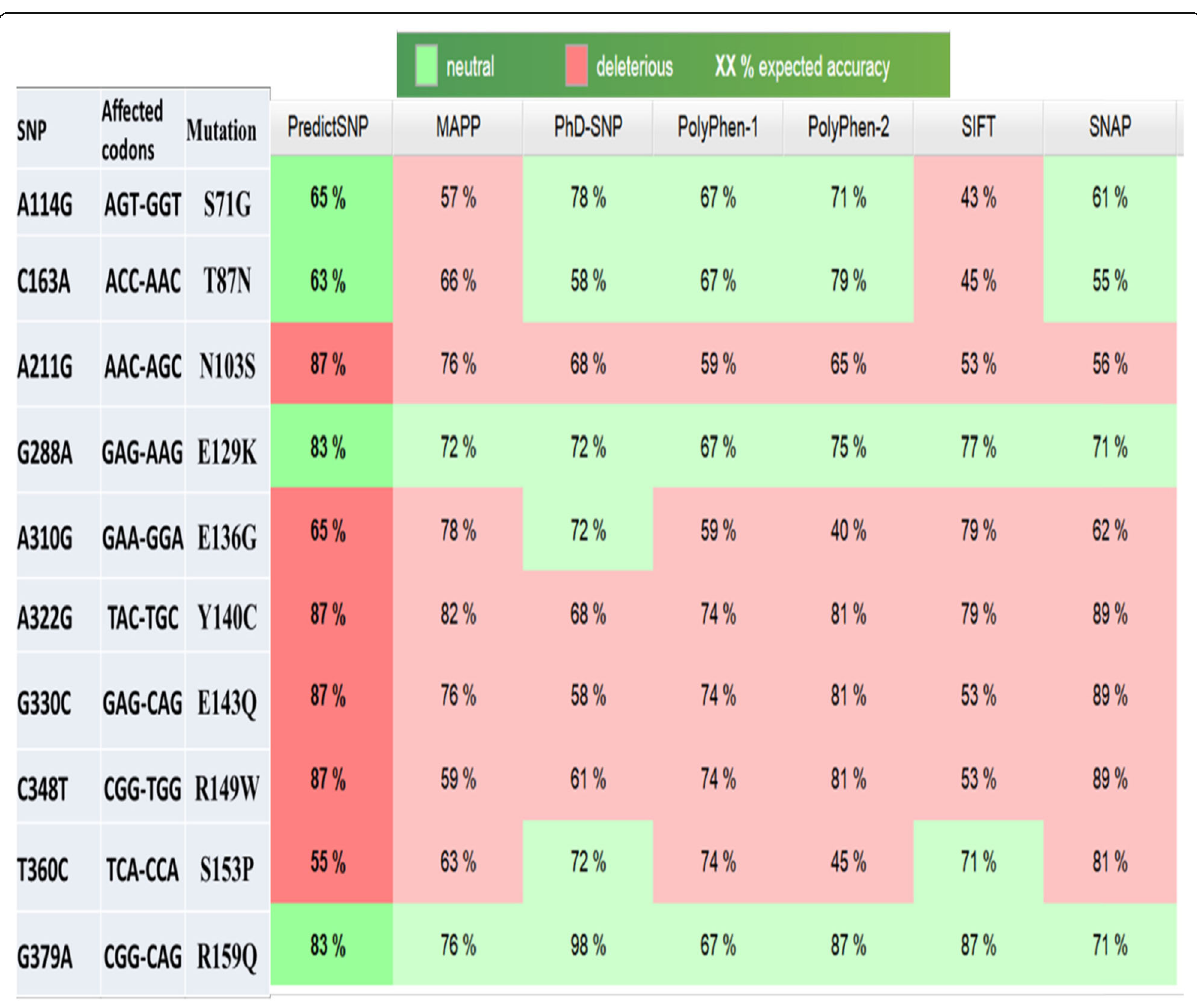
Fig. 4 The effect of non - synonymous SNPs on river buffalo LEP